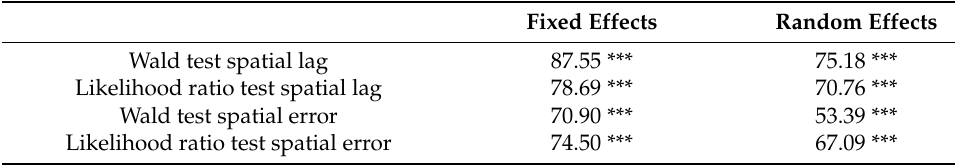
Table 3. The results of Wald and LR